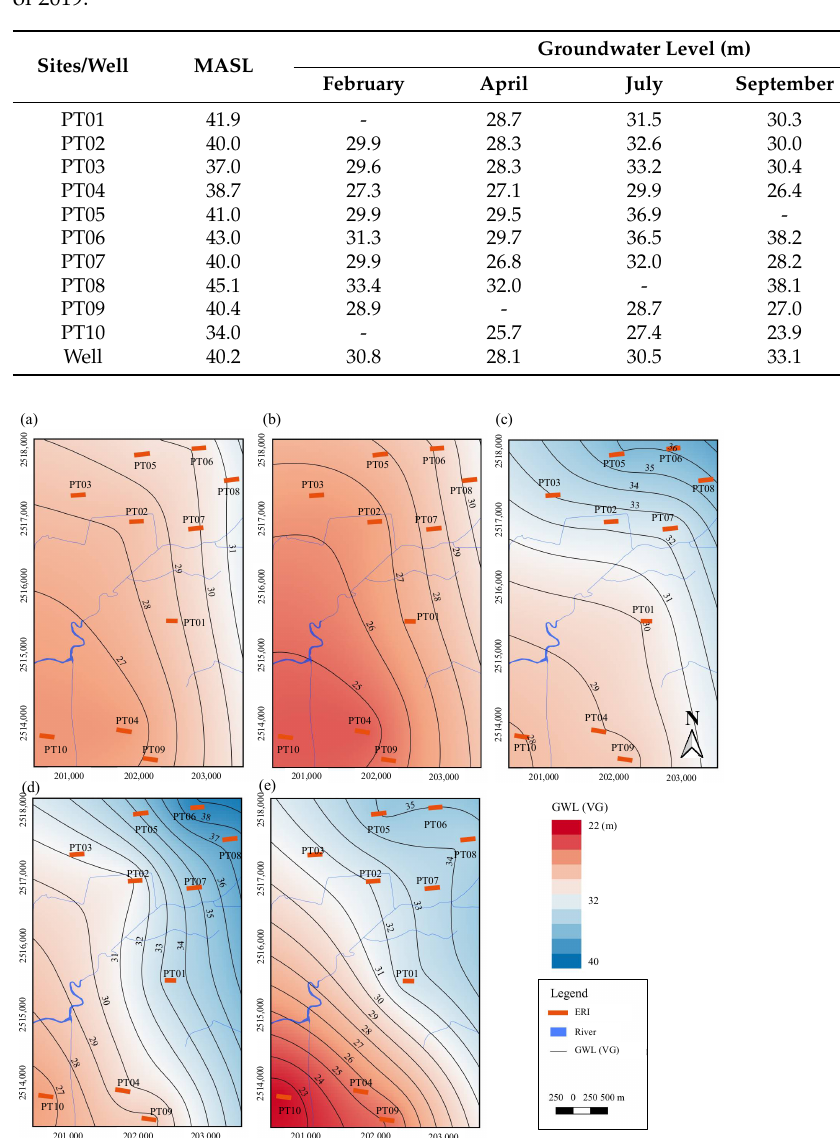
Figure 12. Spatial distribution contour map of the GWL obtained from VG for different months: ( a ) February, ( b ) April, ( c ) July, ( d ) September, and ( e ) November.